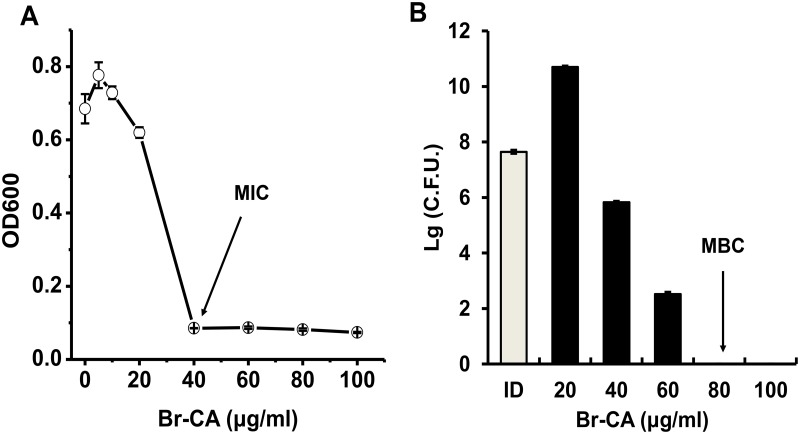
Determination of MIC (A) and MBC (B) of Br-CA against E. coli.MIC was defined as the lowest concentration of Br-CA to completely inhibit cell growth at 37°C in 96 wells plates for 24 hour and OD600 was monitored with the microplate reader to indicate the cell growth. MBC was defined as the lowest concentration of Br-CA to completely eradicate all the cells incubated at 37°C in 96 wells plates for 24 hour and surviving cells were evaluated using drop plating method after serial dilutions. ID stood for the initial cell density. Each data point or bar was indicated as the means of three replicates ± standard deviation.